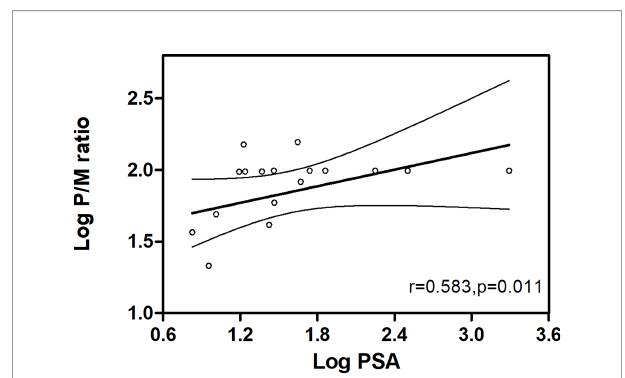
FIGURE 4 | Positive correlation between P/M ratio and PSA levels in